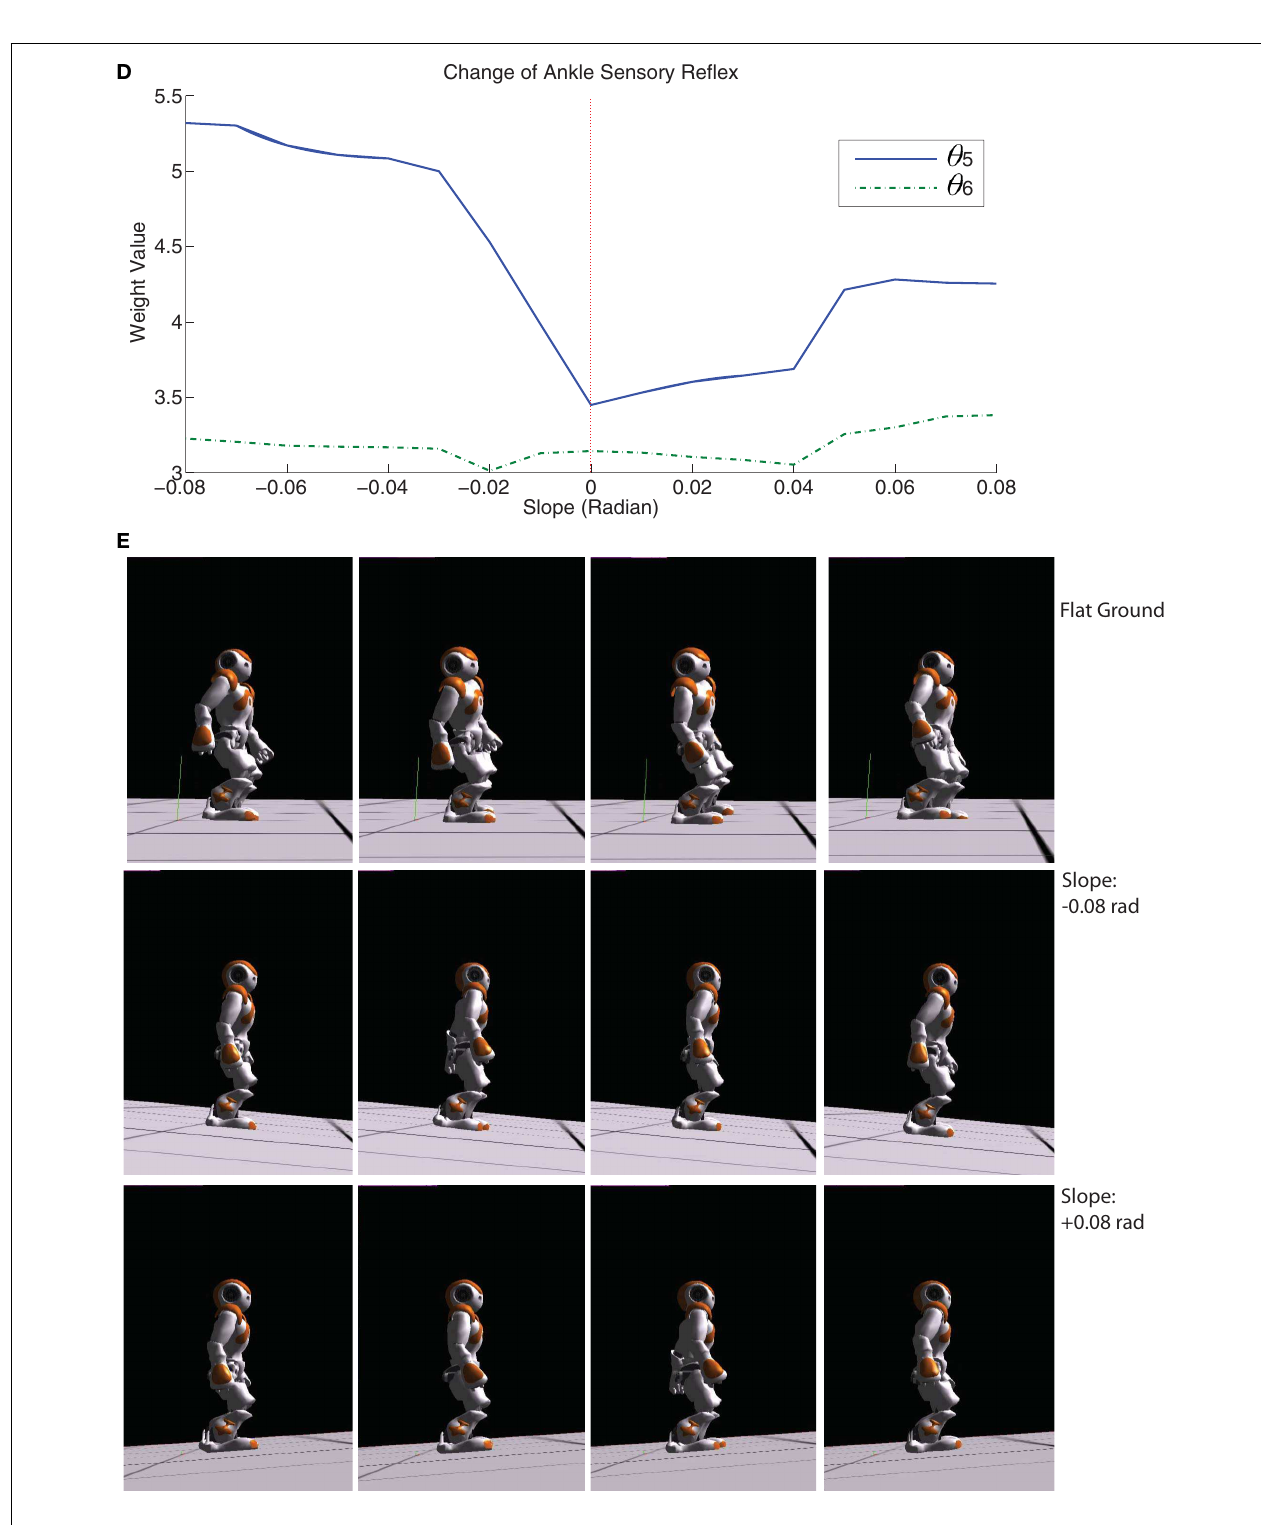
slope based on the strength of sensory feedback. (E) shows the different walking gaits on flat ground and slope ( − 0.08 and + 0.08rad). Please refer to video (Cai,